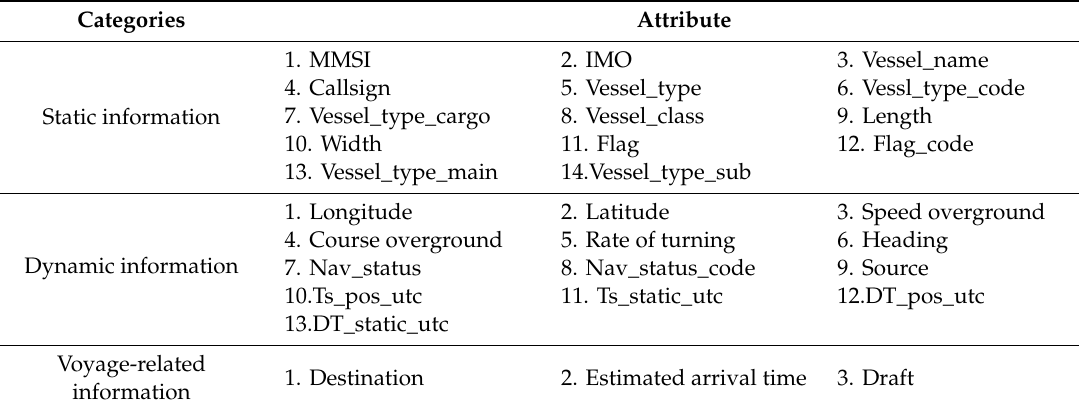
Table 1. Field of automatic identification system (AIS) data.